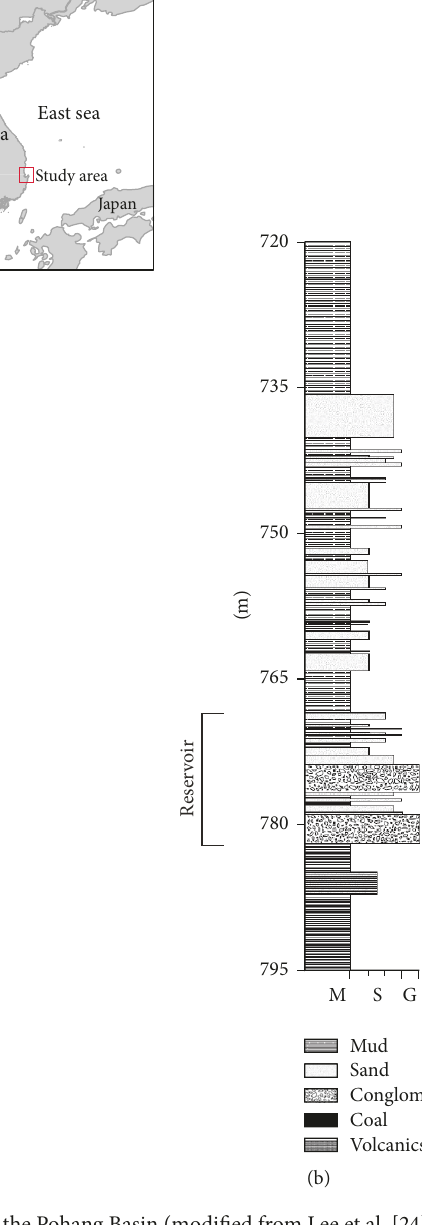
Figure 1: (a) A geologic map of the study area and location of the injection well in the Pohang Basin (modified from Lee et al. [24]) and (b) the sedimentary log of the injection well core (modified from Choi et al.